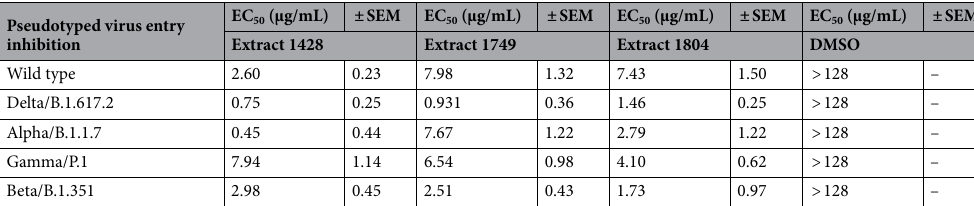
Table 3. EC 50 values were calculated by modeled dose–response curves against the wild type SARS-CoV-2 pseudovirion model using non-linear regression. This experiment was preliminary to help narrow in on potential leads for further characterization. This experiment was performed once in triplicate except for wild- type (n = 6). SEM standard error mean. Accompanying plots can be found in Fig.